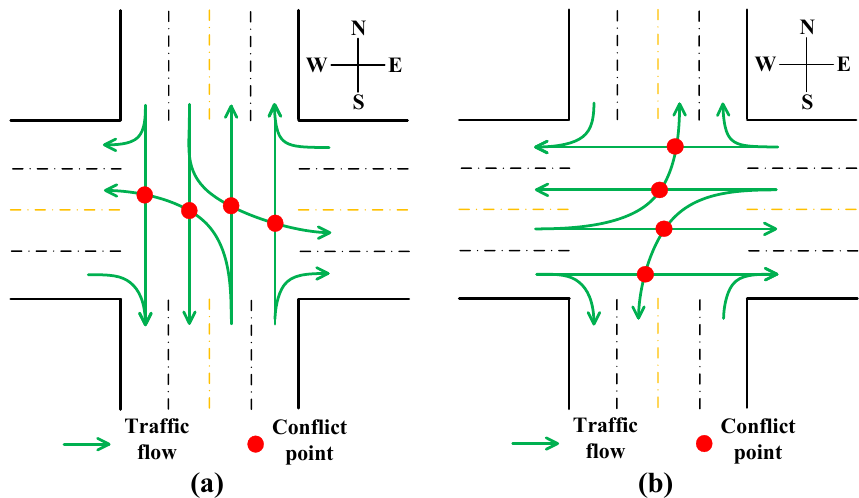
Figure 2. Signal phases: ( a ) First signal phase. ( b ) Second signal